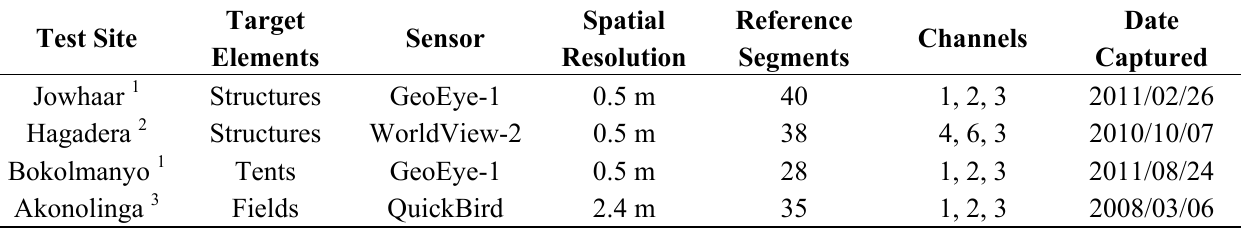
Table 1. Dataset metadata, including the number of utilized reference